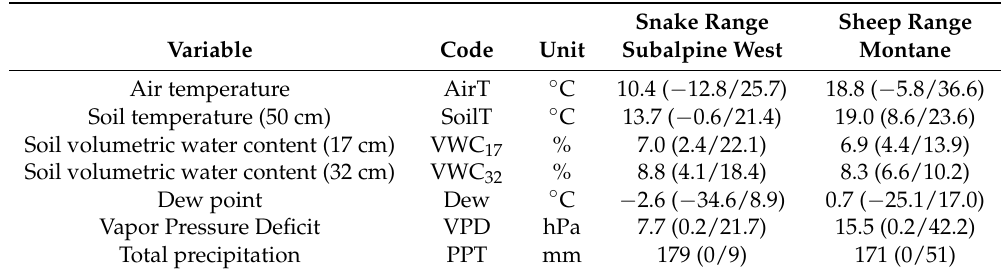
Table 1. Summary of climatic variables included in this study. Hourly means and range (minimum/ maximum) are shown for the June-September period during 2013–2015 (average climate conditions for the whole year are shown in Figure